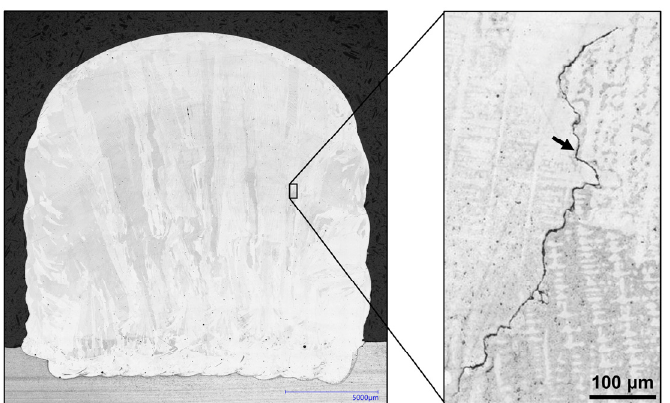
Figure 7. Optical microscope image of specimen S13. The arrow indicates the location that is shown at a higher magnification in Figure 8.